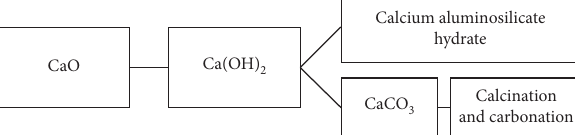
Figure 2: Inorganic reaction part of pozzolanic reaction.